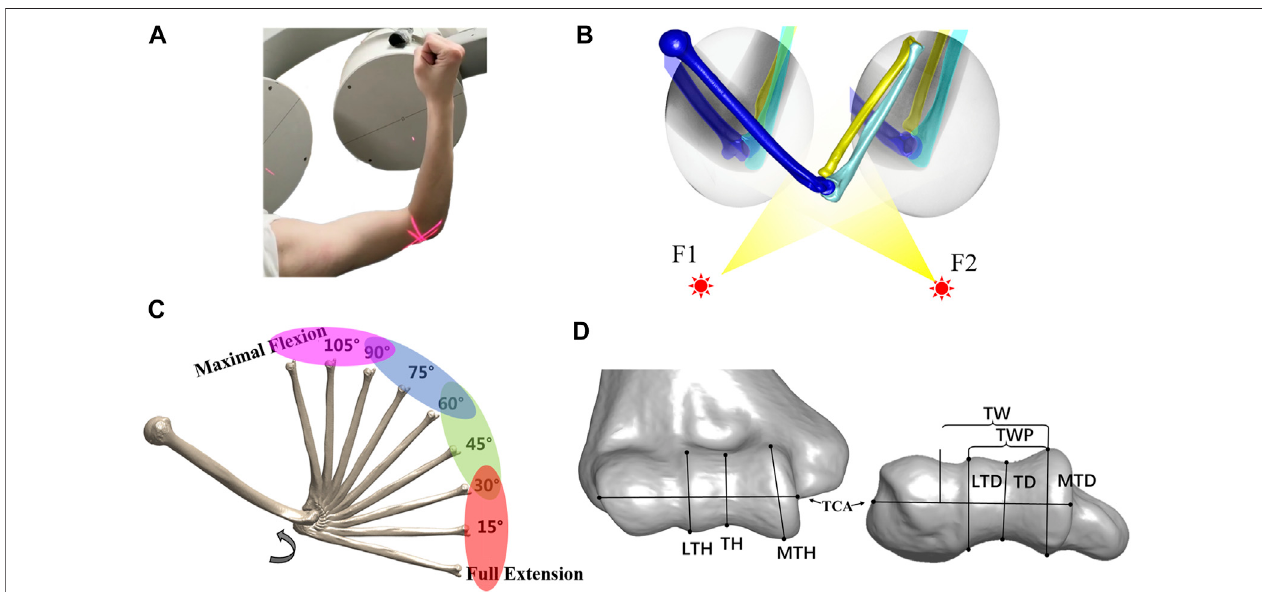
FIGURE 1 | Experimental work fl ow. (A) Each subject performed a full extension to maximal fl exion under a biplane fl uoroscopic imaging system. (B) Virtual experiment environment of 3D – 2D registration for acquiring the in vivo elbow fl exion kinematics. (C) Range of the fl exion was divided into four phases at full extension